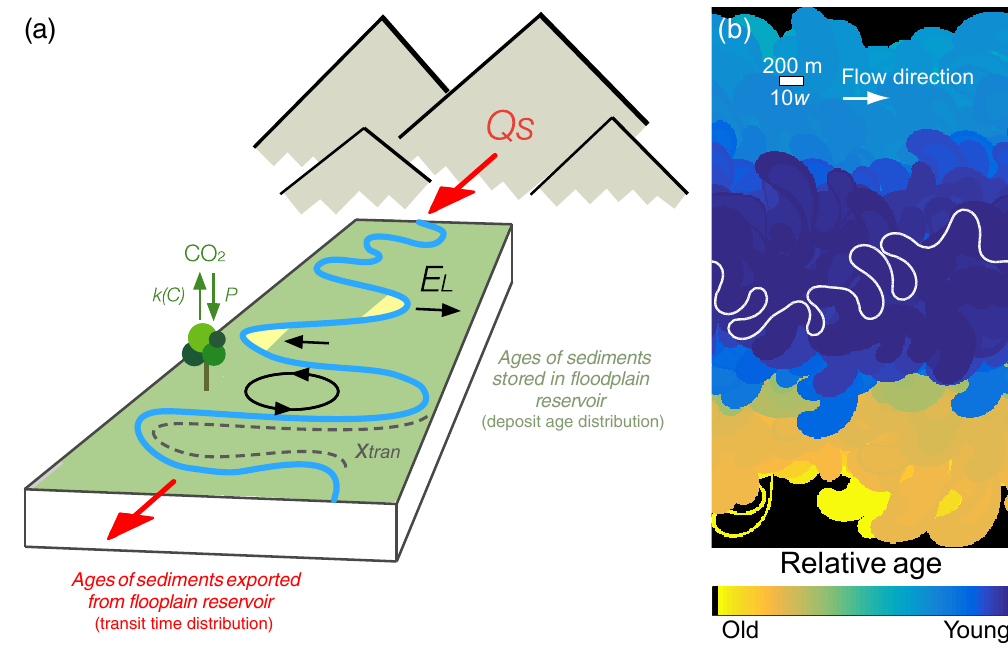
Figure 1. Model schematics highlighting key geometric relationships. (a) The sediment flux ( Q s ) from an upstream area is routed though an alluvial valley. As a result of lateral channel migration ( E L ), sediment deposits are created and eroded leading to transient sediment storage. During sediment storage, the fixation of atmospheric CO 2 by biota leads to the production ( P ) of particulate organic carbon (C), which is degraded back to CO 2 at a rate ( k ) proportional to its concentration in sediments. As sediments (and POC) move downstream, they can be re-deposited and stored. Here, we define a characteristic length scale ( x tran ) that reflects the distance sediments travel before being re-deposited. The ages of sediments and organic carbon can be described by two distributions. The transit time distribution describes the ages of material being actively removed from the system by erosion and thus have reached maximum age. The deposit age distribution describes the ages of material that remains stored in river deposits and will continue to age until subsequent erosion. (b) A map view of example model output where the white line shows the final position of the river channel, which flows from left to right across the model domain. Sediment ages range from relatively old (yellow and orange) at the lower edge of the domain to relatively young (blue) nearer the channel. Areas of the model domain not visited by the channel are shaded